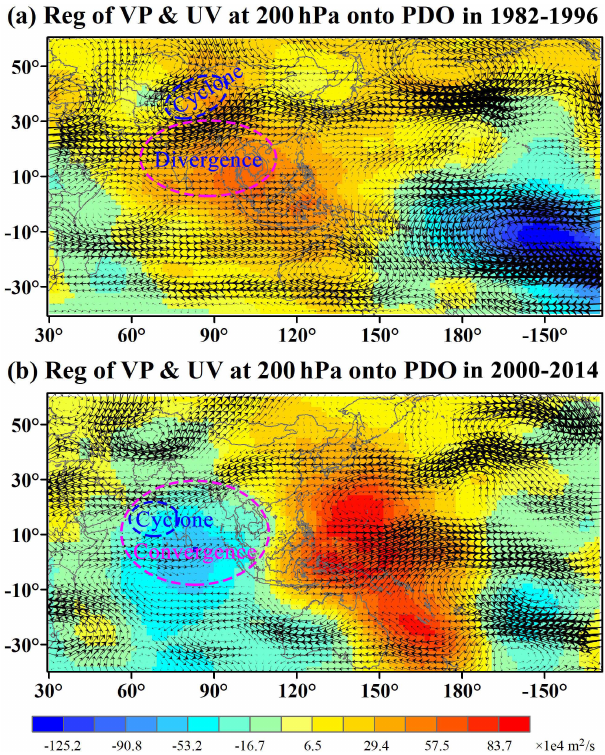
Figure 16. (a) Regression of summer (June–July) velocity potential at 200hPa onto previous winter PDO (averaged from November to January) overlaid with the average of summer wind in positive PDO years during 1982–1996. (b) Regression of summer velocity poten- tial at 200hPa onto previous winter PDO overlaid with the average of summer wind in negative PDO years during